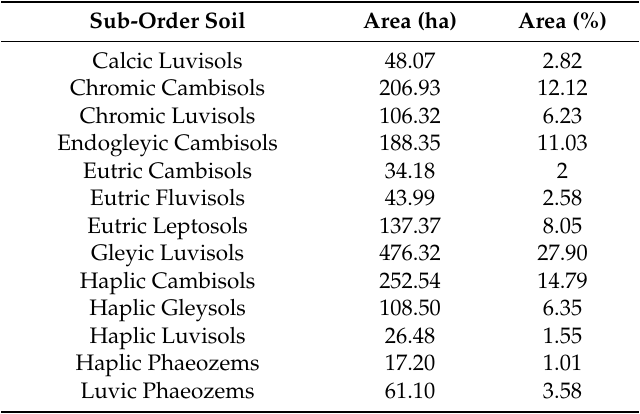
Table 4. Characteristics of Sub-order types of